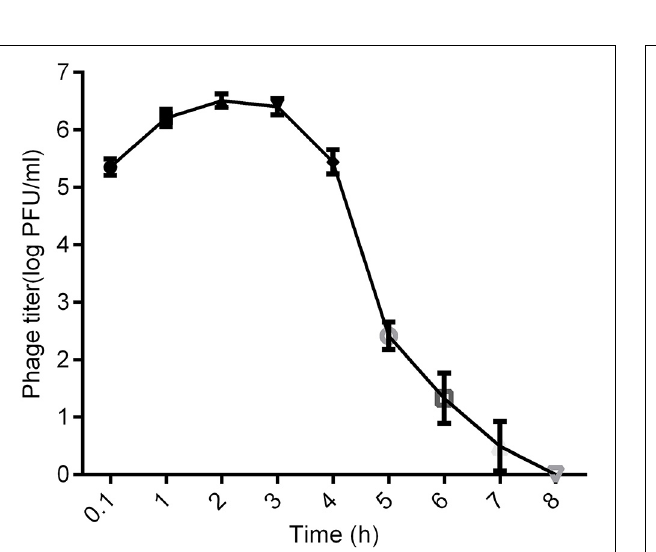
FIGURE 5 | Distribution of kpssk3 in the blood of healthy mice at different time points after intraperitoneal injection with 1 ml of 10 8 PFU/ml kpssk3. detected in blood 6 min after intraperitoneal administration of kpssk3. The phage titer in the blood peaked within the first hour and remained relatively high for 4 h, which made